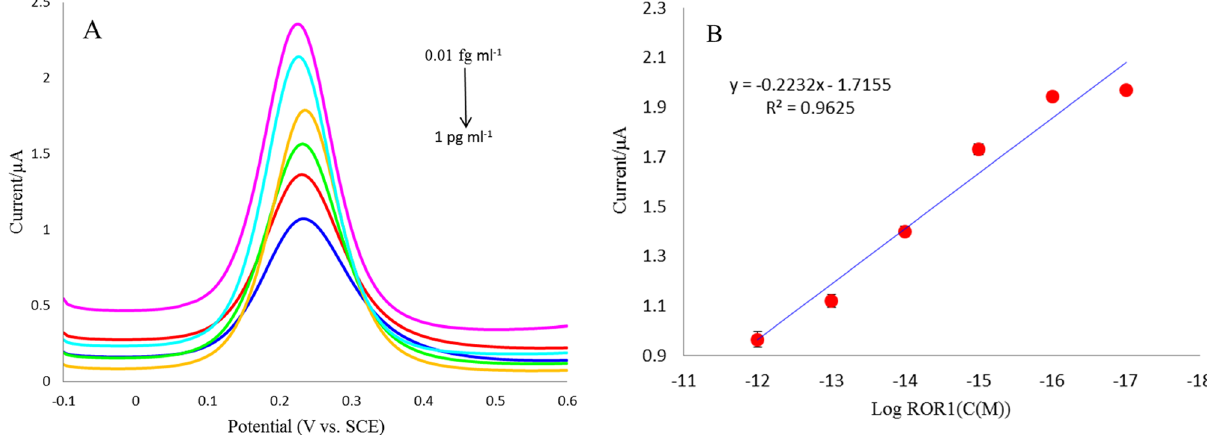
Figure 4. ( A ) DPV curves of the immunosensor after incubation with different concentrations of ROR1 (0.01 fg mL −1 , 0.1 fg mL −1 , 1 fg mL −1 , 0.01 pg mL −1 , 0.1 pg mL −1 , 1 pg mL −1 ). ( B ) The linear relationship between the peak current versus the logarithm concentration of ROR1 in the range of 0.01 fg mL −1 to 1 pg mL −1 . Error bars represent standard deviation (n =